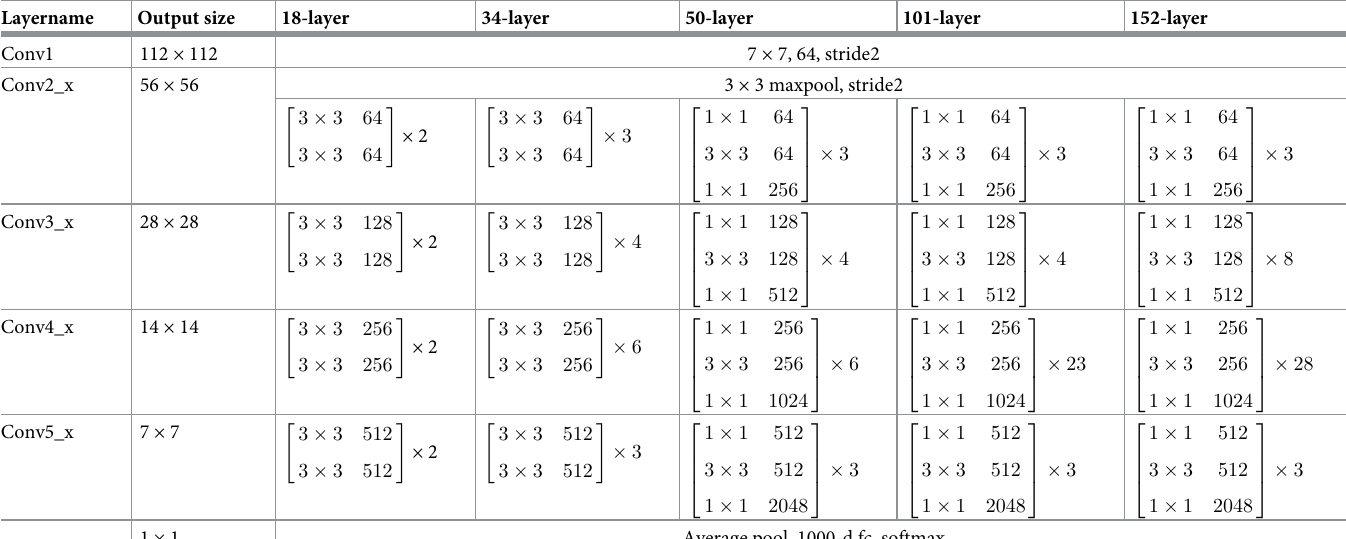
Table 2. Comparison of various ResNet networks.